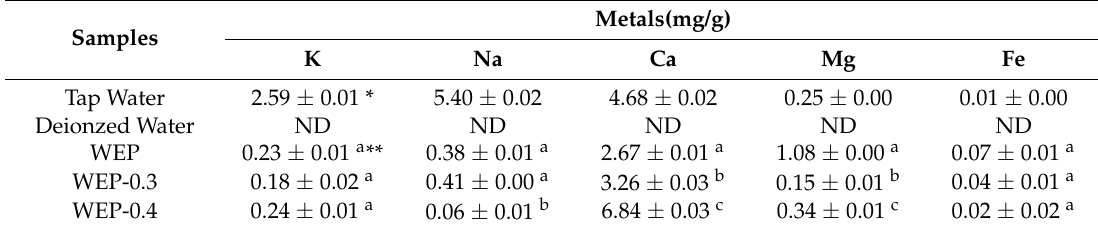
Table 2. Composition and amounts of metals in WEP and its